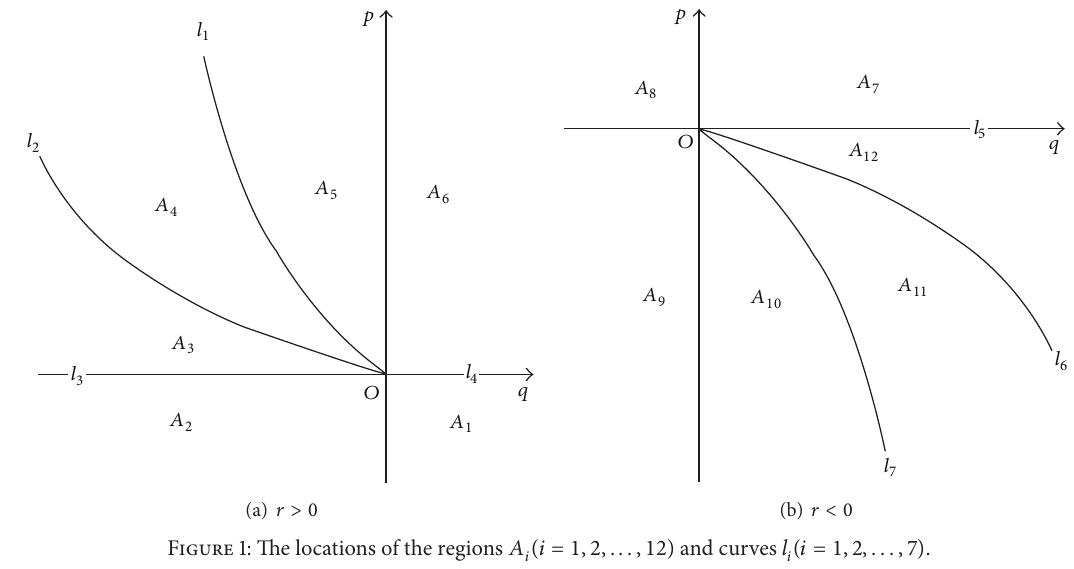
Figure 1: The locations of the regions 𝐴 𝑖 (𝑖 = 1,2,...,12) and curves 𝑙 𝑖 (𝑖 = 1,2,...,7)